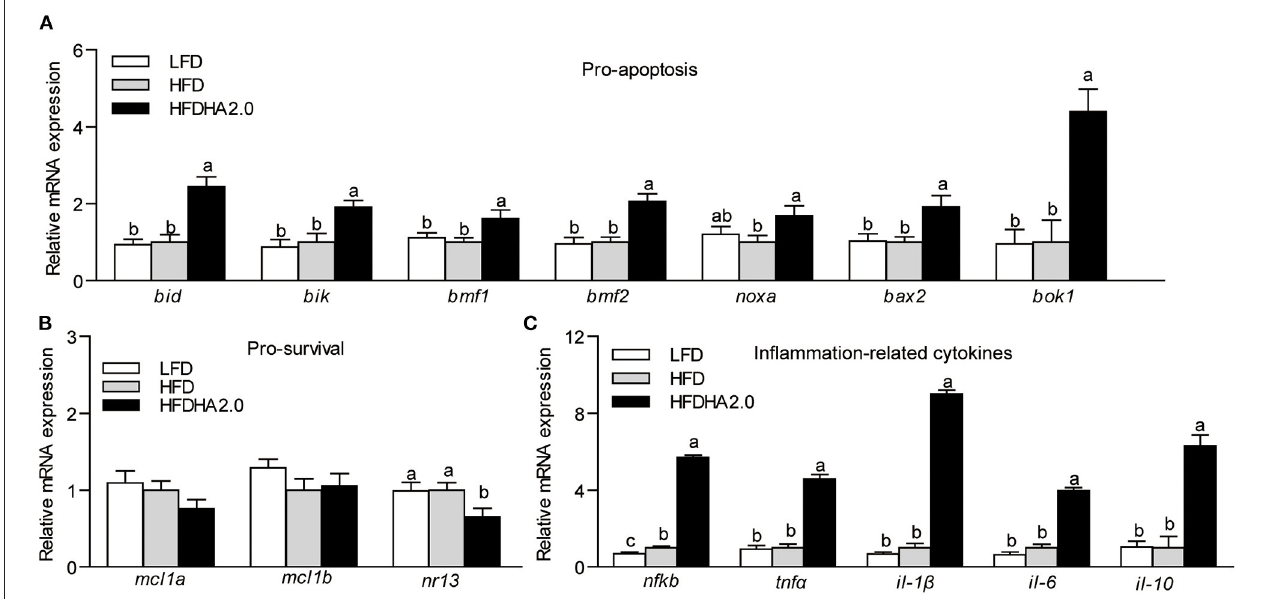
FIGURE 4 | The effects of DHA on the relative mRNA expression of Bcl-2 family and inflammation-related cytokines in the livers of zebrafish. (A) The relative mRNA expression of pro-apoptotic proteins of LFD, HFD, or HFDHA2.0-fed zebrafish. (B) The relative mRNA expression of pro-survival proteins of LFD, HFD, or HFDHA2.0-fed zebrafish. (C) The relative mRNA expression of inflammatory cytokines of LFD, HFD, or HFDHA2.0-fed zebrafish. The values are means ± SEMs ( n = 4–6 biological replicates). The mean values without a common letter are significantly different, p < 0.05. LFD, low-fat diet; HFD, high-fat diet; HFDHA2.0, 2% DHA-supplemented